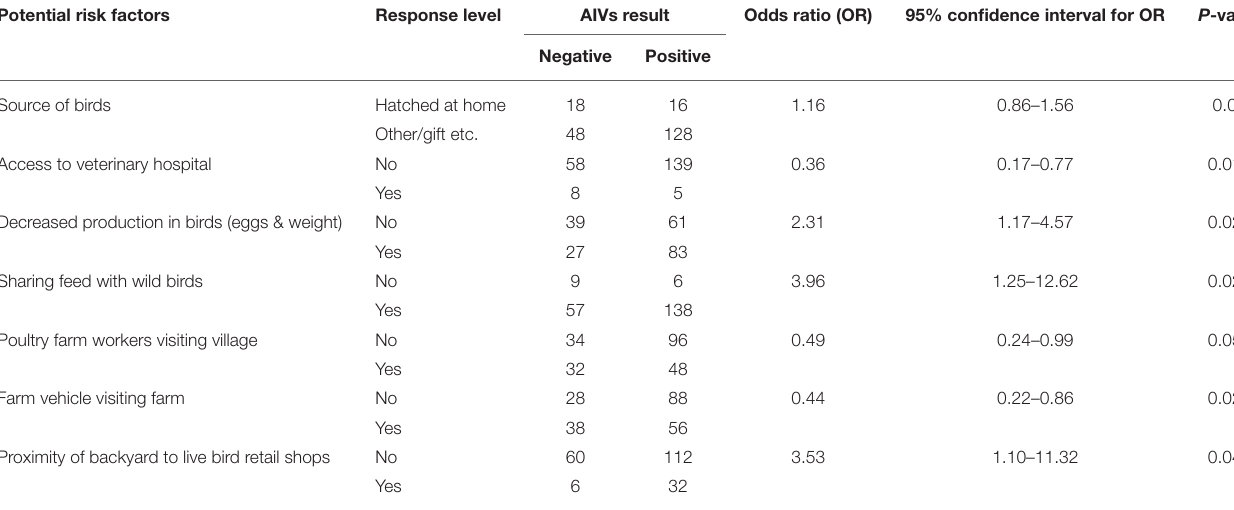
TABLE 3 | Results of univariable analysis with potential risk factors associated with the seroprevalence of AIVs in backyard poultry of villages of Lahore district. Potential risk factors